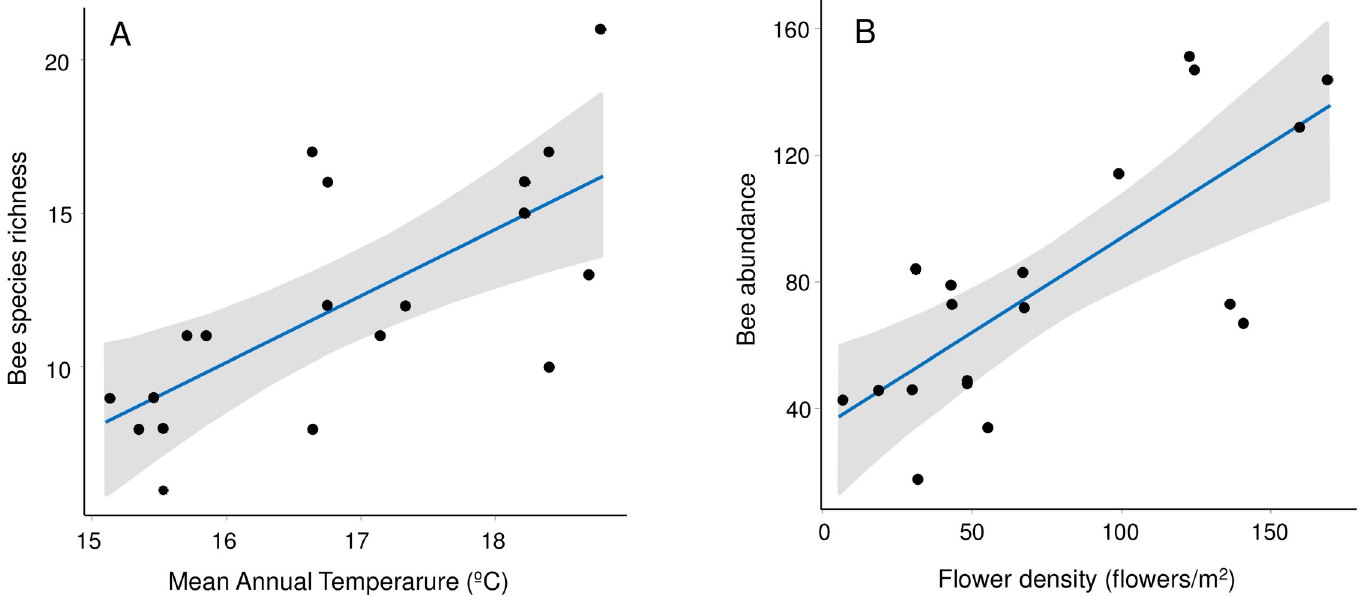
Fig 3. Best GLS models relating bee response variables vs climatic and flower variables. (A) Bee species richness vs Mean Annual Temperature (MAT;˚C), and (B) bee abundance vs flower density (number of flowers/m 2